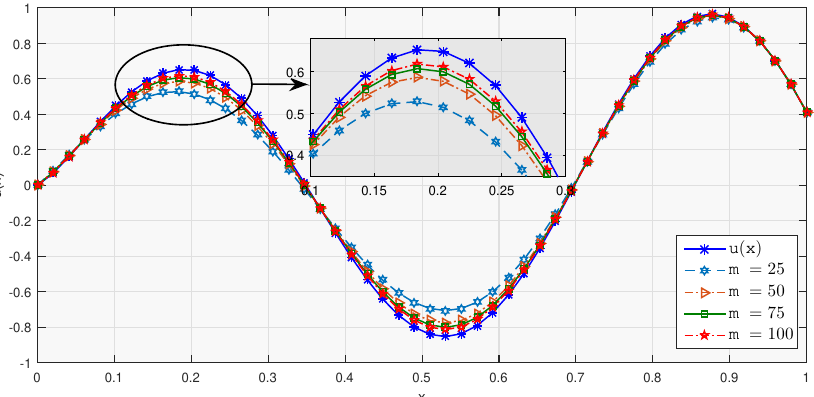
Figure 2. Test function (Blue-Star) and new construction of Meyer–König and Zeller operator with the given parameters, α n ( x ) , β n ( x ) , and ρ ( x ) on uniform grid; m = 25 (Marine-Hexagram), m = 50 (Orange-Right Pointing Triangle), m = 75 (Green-Square), m = 100